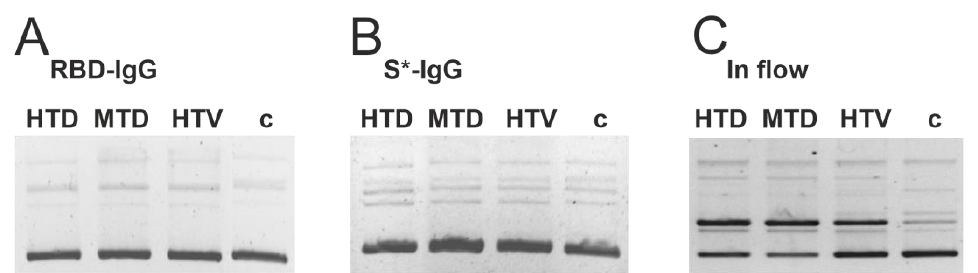
Figure 8. The DNA-hydrolyzing activity of anti-RBD-IgG ( A ) and S*-IgG ( B ) of HTD, MTD, and HTV groups. As a control, the activity of the pooled IgG preparation from 25 patients after anti-RBD-IgG and S*-IgG isolation is shown ( C ). The activity was evaluated in the cleavage of double-stranded super-stranded (sc) plasmid DNA pBluescript. The c-track corresponds to supercoiled plasmid DNA incubated without antibodies.